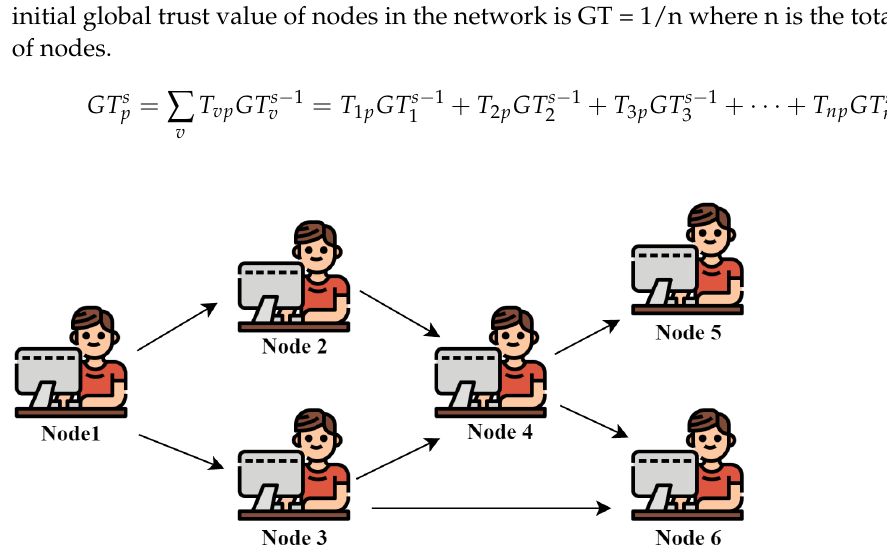
Figure 3. Node architecture with direct and indirect